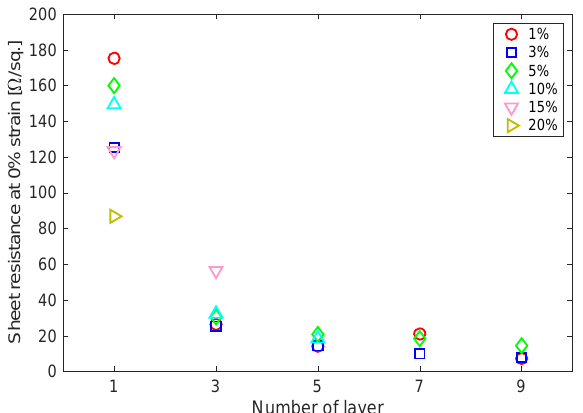
Figure 9. Sheet resistances of the corrugated PEDOT:PSS thin film specimens exponentially decreases as the number of deposited PEDOT:PSS layer increases. Pre-strain shows the strongest effect in sheet resistance for the 1 layer case. But, it becomes weaker as the number of layers increase.